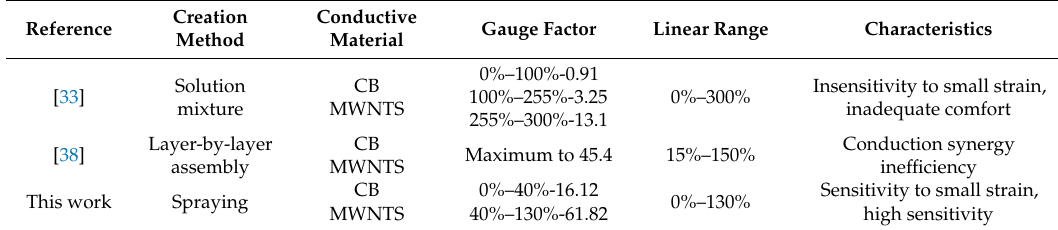
Table 1. Comparisons of the performances of flexible strain sensing